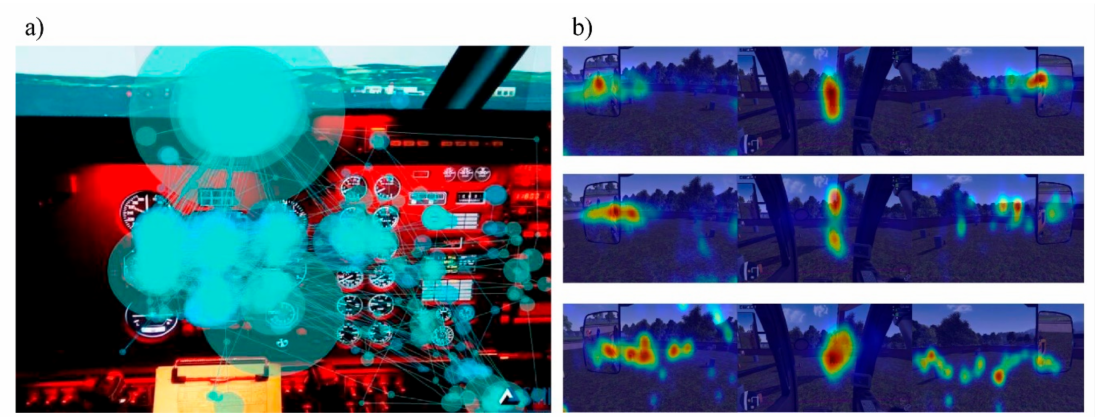
Figure 6. ( a ) Pilot scanpath of cockpit flight instruments during a landing approach [75]; ( b ) Excavator operator gaze point distribution heatmap